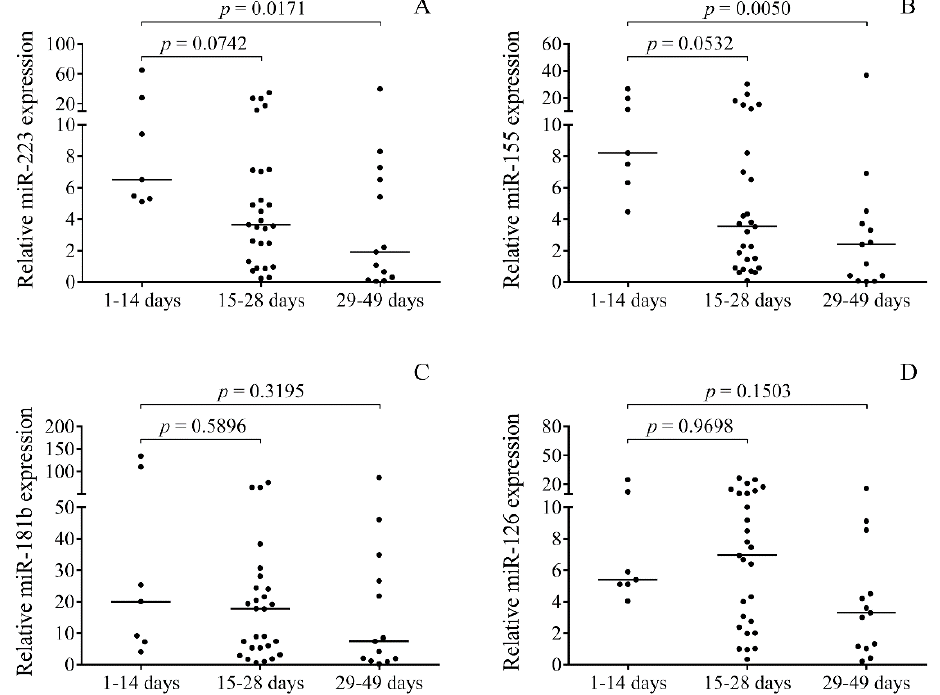
Figure 2. CSF samples were obtained at different time points after the onset of IVH; accordingly, the samples were subdivided into three groups, 1–14 days ( n = 7), 15–28 days ( n = 27), and 29–49 days ( n = 13). Even higher miR-223 ( A ) and miR-155 ( B ) expressions were detected in those specimens collected within two weeks after the onset of IVH compared to those collected afterwards. However, miR-181b ( C ) and miR-126 ( D ) did not significantly alter within this time period. Dots represent single expression values. Median values are depicted. Kruskal–Wallis test with Dunn’s multiple comparisons test was performed for the comparison. CSF: Cerebrospinal fluid, IVH: Intraventricular hemorrhage.